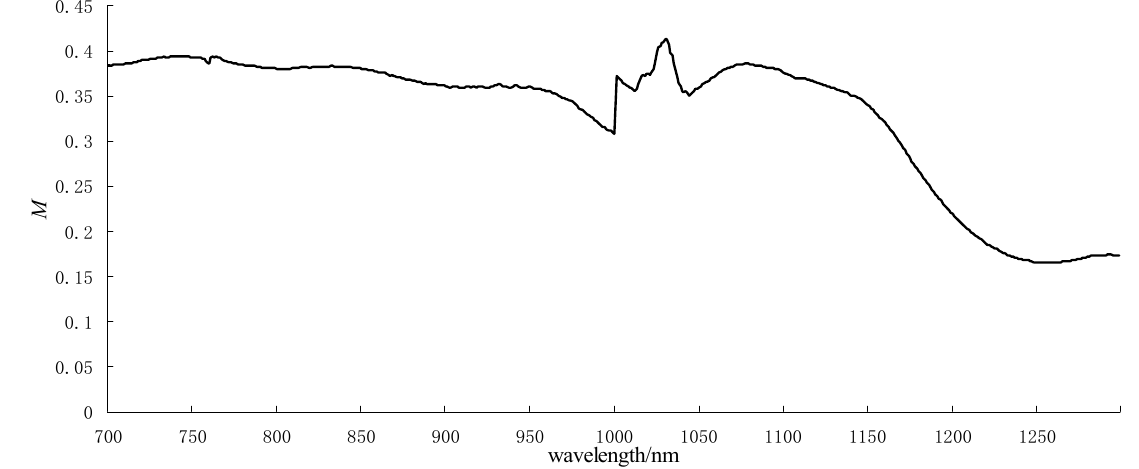
Figure 8. The distribution of the M value along the wavelength